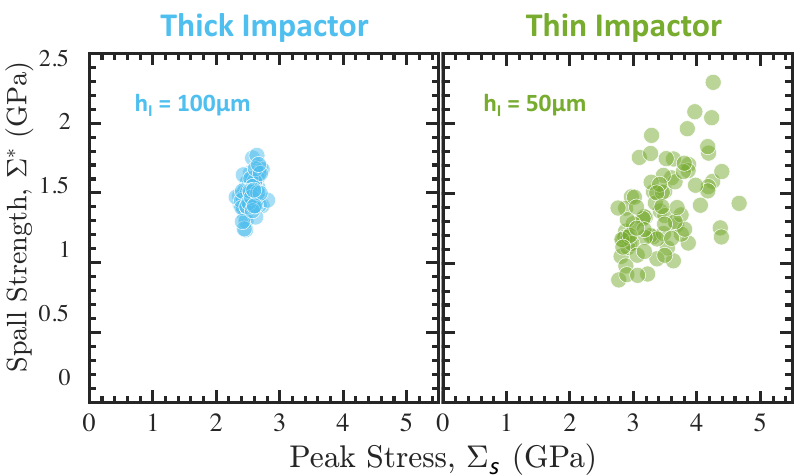
Figure 4. The influence of impactor thickness on the peak shock stress. Σ ∗ vs. Σ S for ( left ) 6A As-Cast impacted with h I = 100 µ m and ( right ) 6A STEP impacted with h I = 50 µ m.